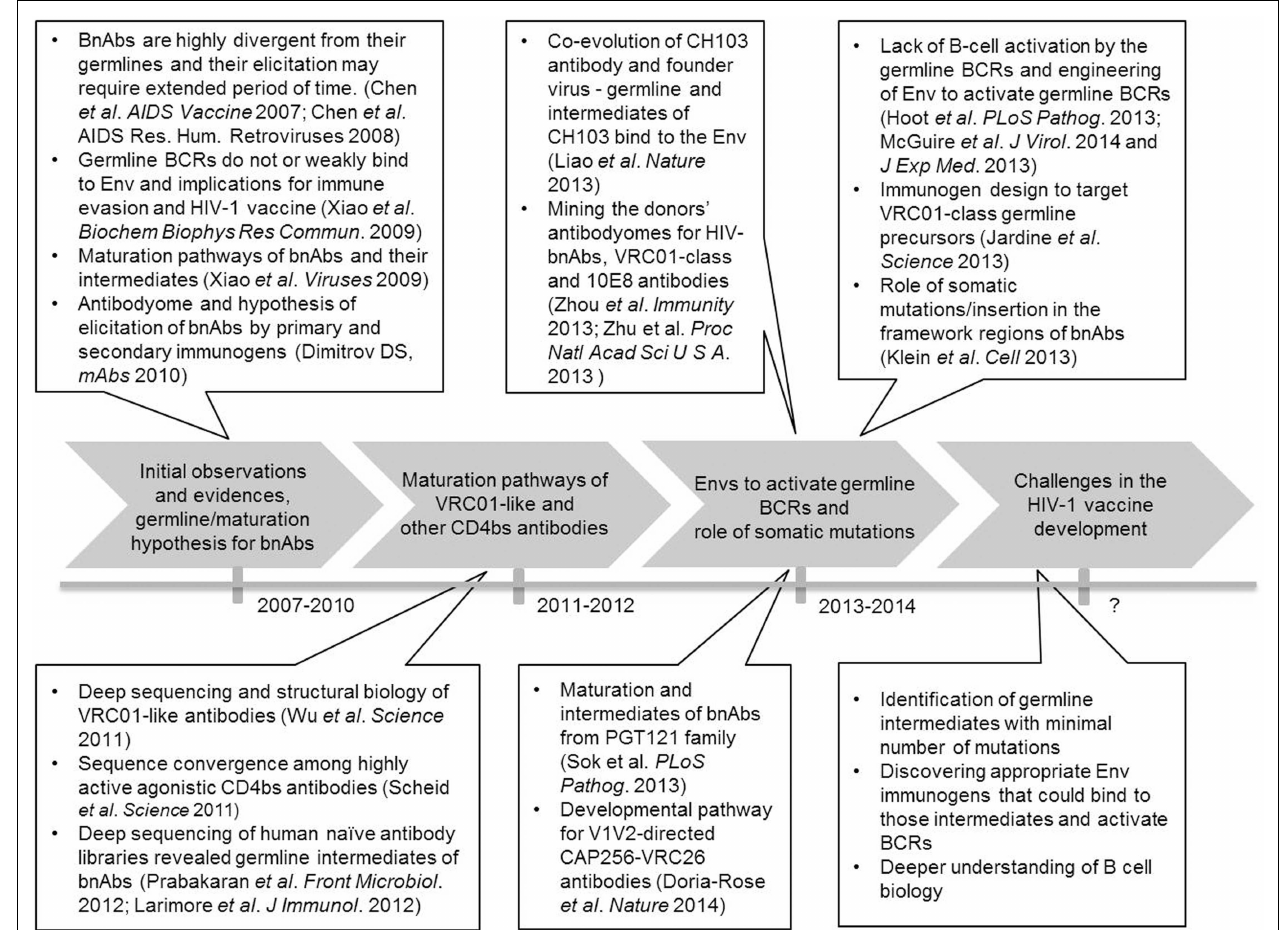
FIGURE 1 |Timeline of the antibody germline/maturation hypothesis and experiments